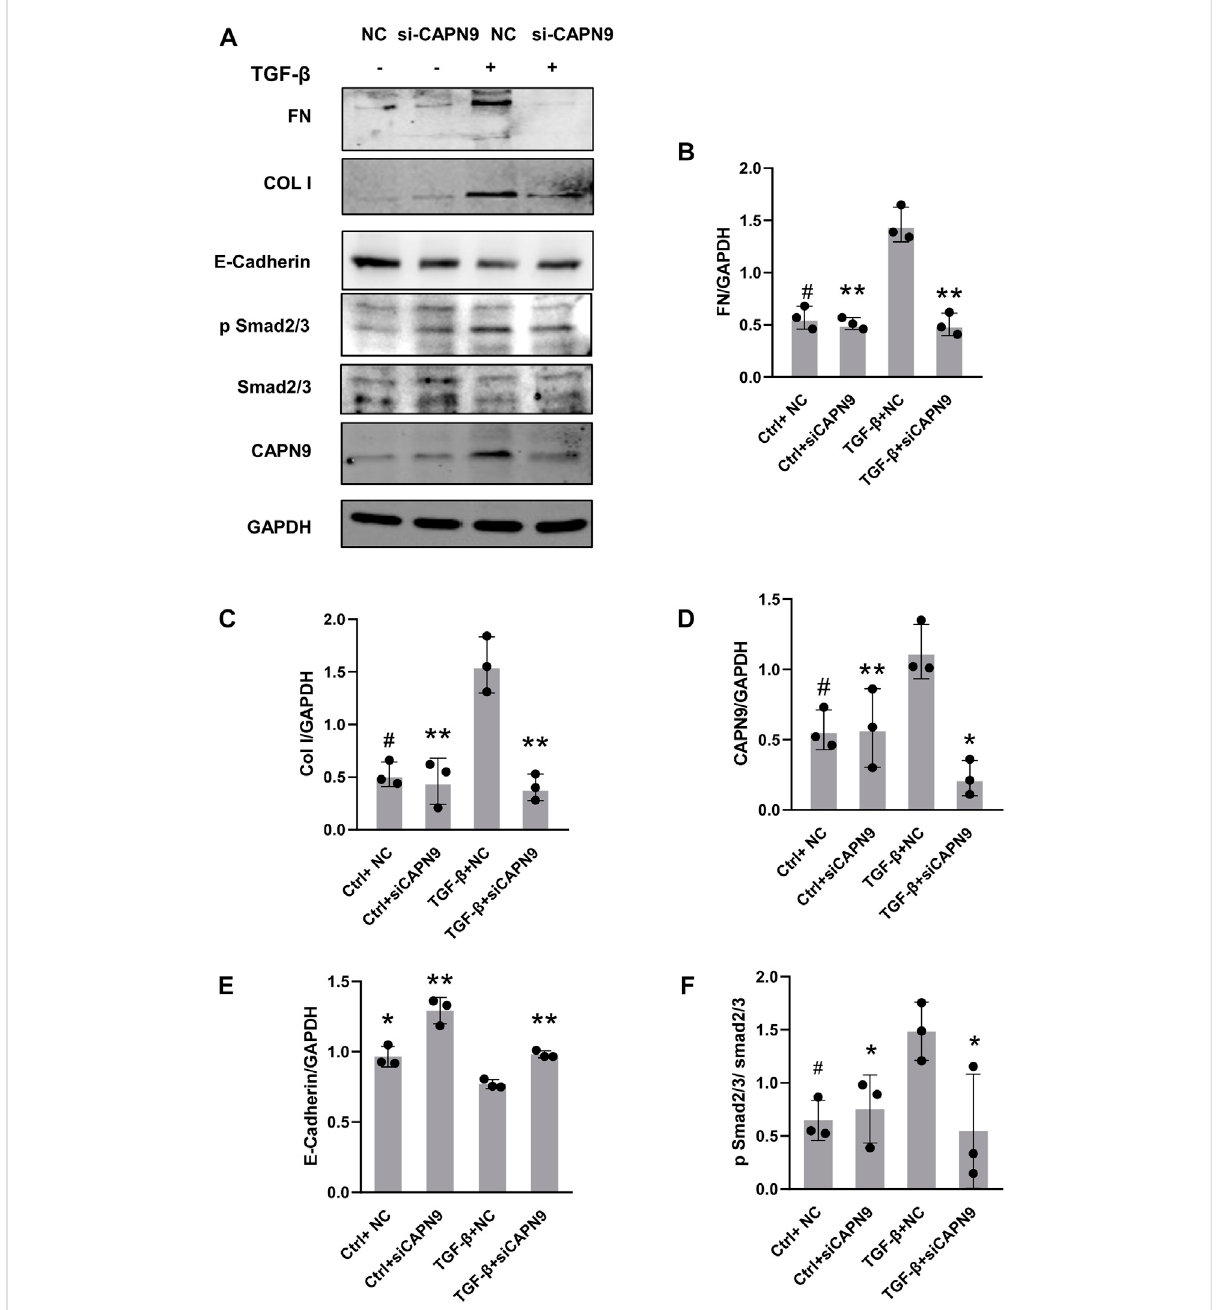
Calpain9 de fi ciency attenuated TGF- β -induced ECM protein expression and EMT. (A – F) Western blot showed Fibronectin (FN), Collagen I (Col I), Calpain9 (CAPN9), E-Cadherin, p Smad2/3 and Smad2/3 expression in whole cell lysates with or without TGF- β , HmrSV5, NC control or